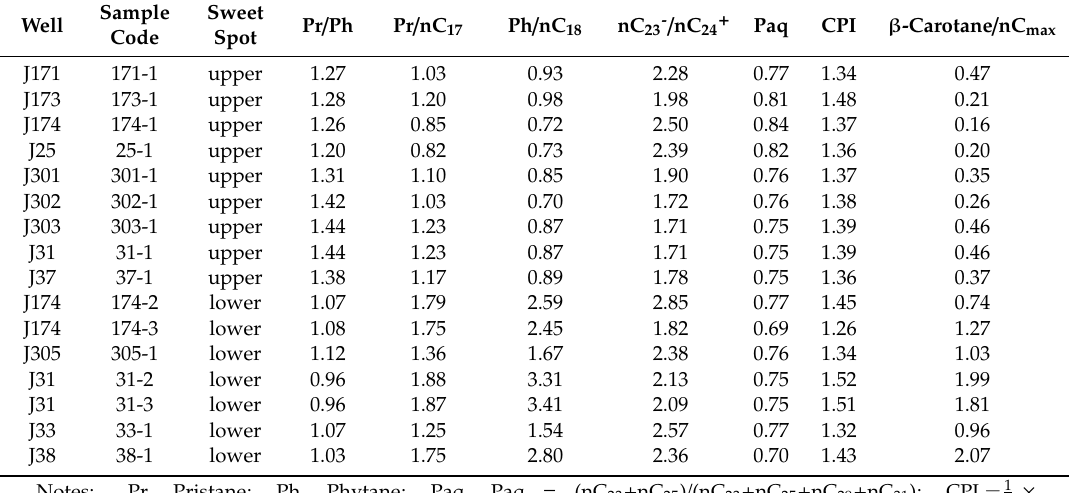
Table 1. Saturated hydrocarbon gas chromatogram parameters of Lucaogou Formation shale oil in Jimsar